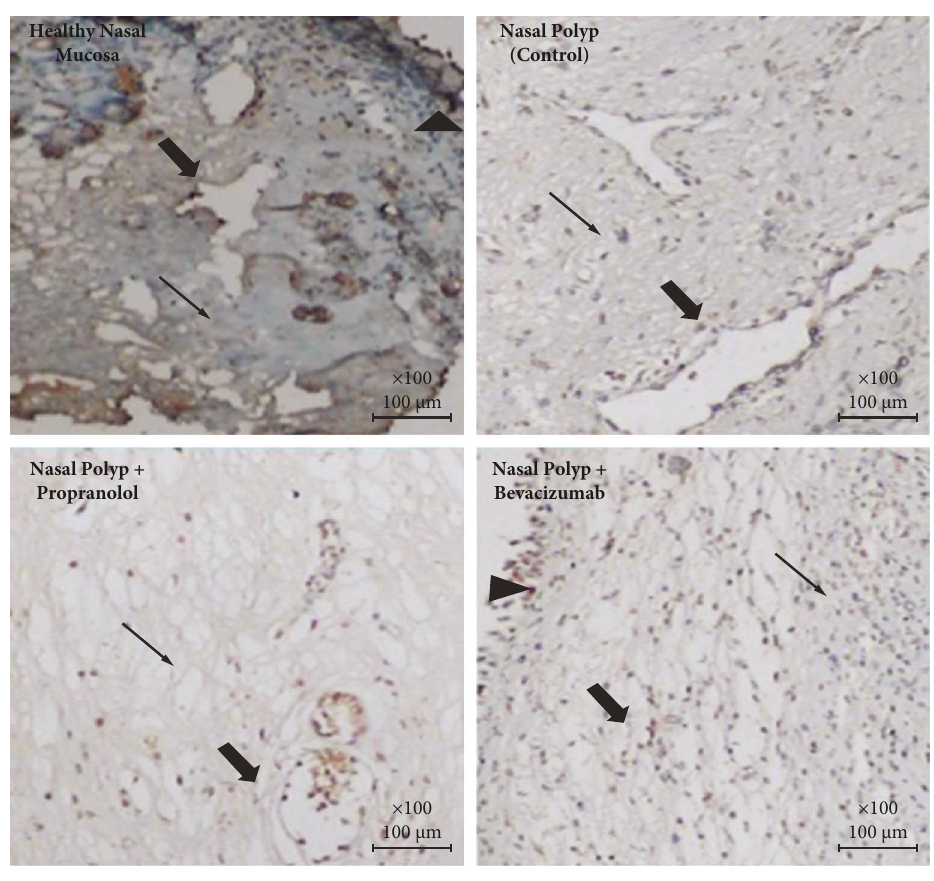
Figure 3: Ang-2 expressions on each group: A slight expression is observed in normal mucosa and nasal polyp group; this expression was high in propranolol and bevacizumab group (thick arrow: capillaries, thin arrow: intersisium (Ang-2, IHC, DABx40).